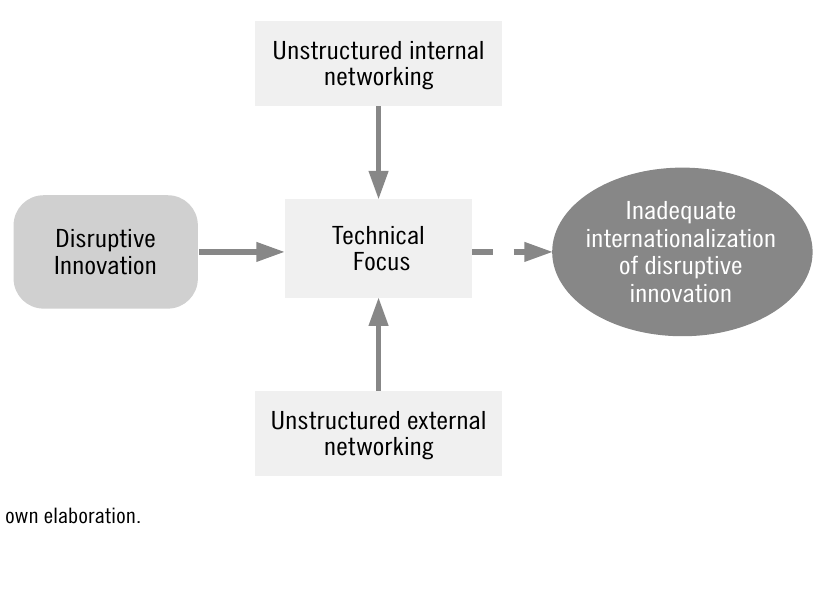
Figure 1. The knowledge before the development phase of SMEs disruptive innovation